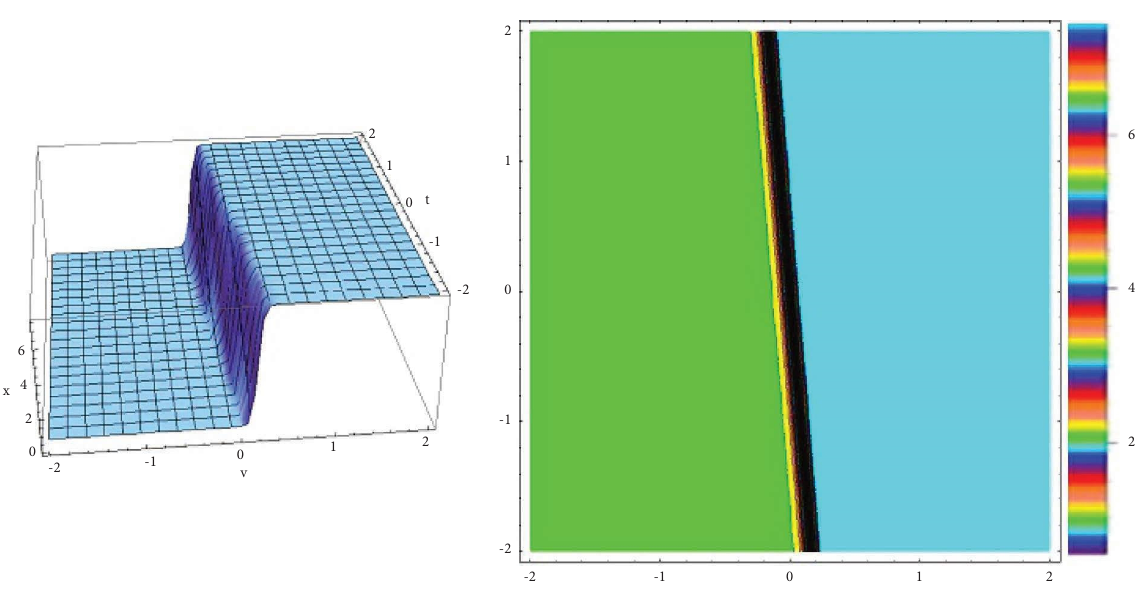
Figure 11: Kink soliton drawing from (36) for ω �